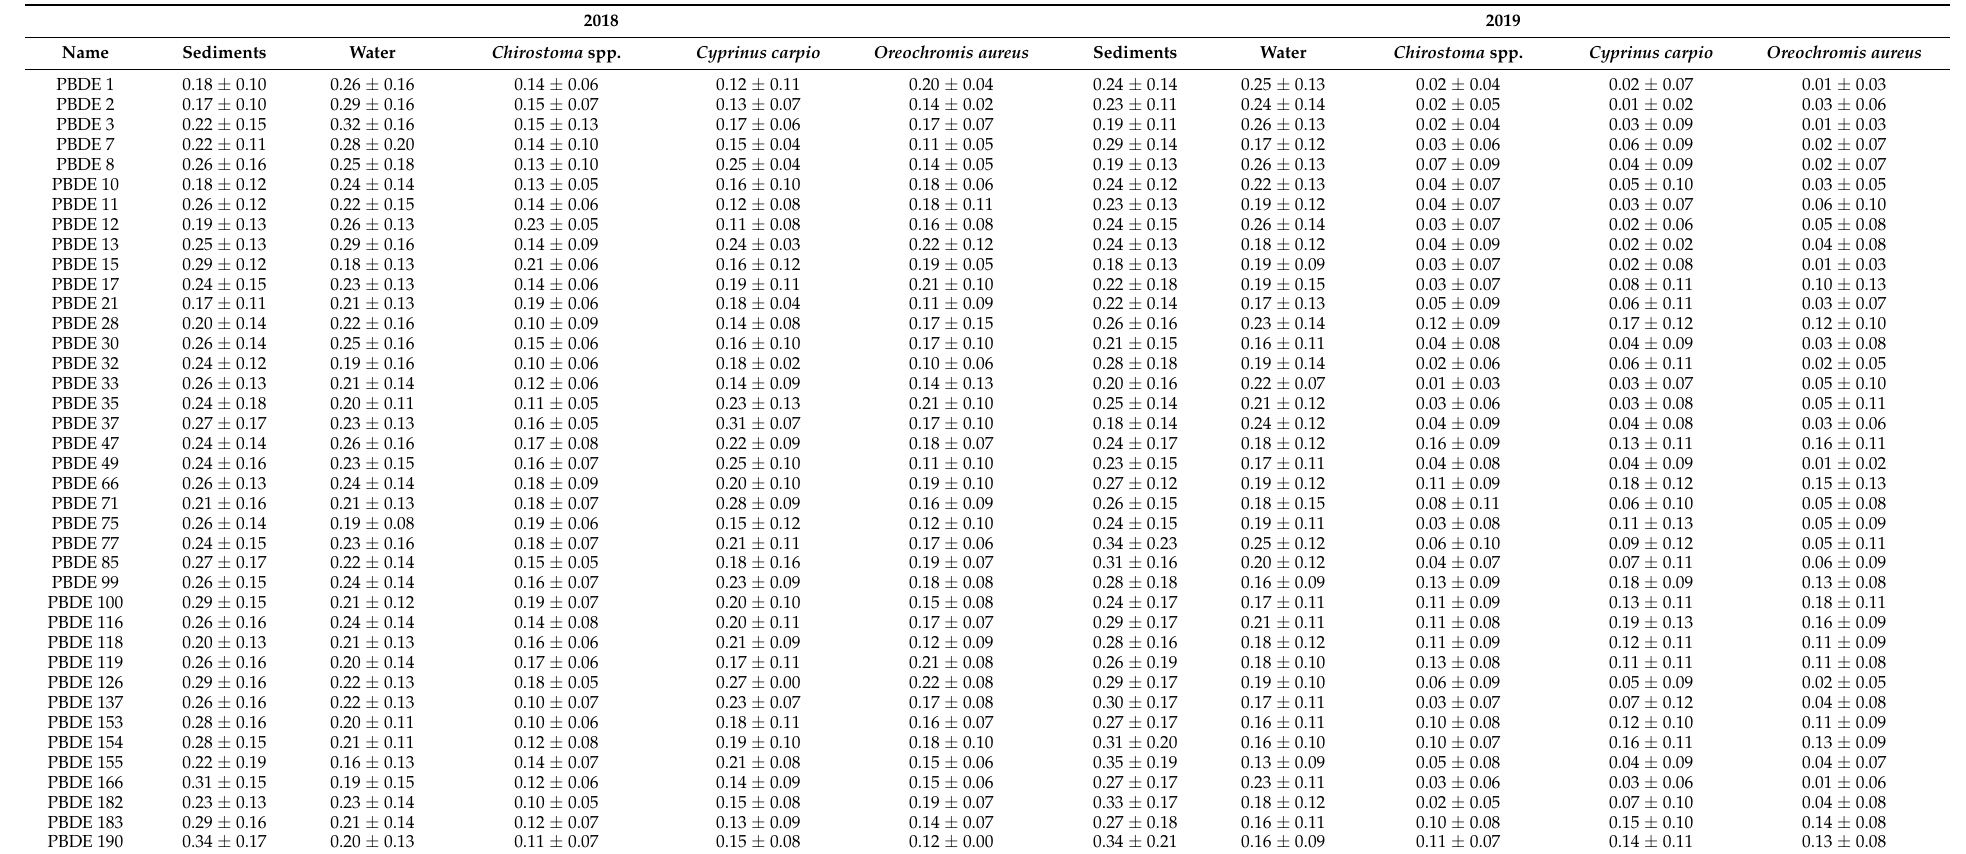
Table 3. PBDE concentrations in matrices of: sediments, water, and fish species from Lake